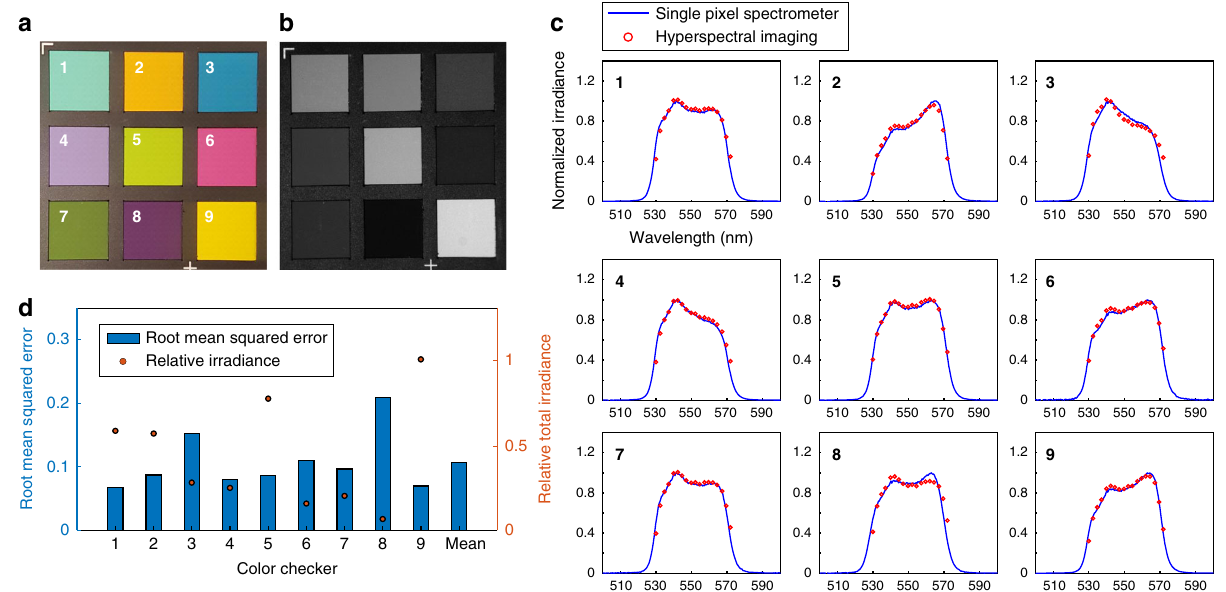
Fig. 8 Technical evaluation of ( x , y , λ ) imaging with direct optical mapping. a Photogram of the colour checker captured by a colour camera when it was illuminated by a fl uorescent lamp. b Photogram of the colour checker captured by a monochromatic camera when it was illuminated by the green light (CWL = 550 nm, FWHM = 40 nm). c Normalised spectral irradiances of light scattered from the colour checker measured by multidimensional photography and a fi bre spectrometer. The graphs indicate that our method can capture the hyperspectral datacube with high fi delity. d Root-mean- squared error (RMSE) of the hyperspectral images captured by multidimensional photography. The averaged RMSE value was